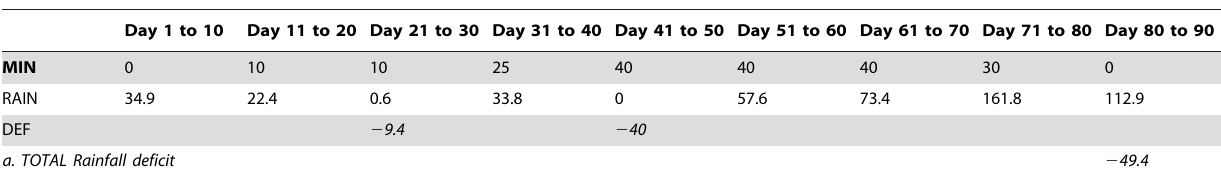
Table 4. Example of a season not entitled to an indemnity payment (total rainfall deficit does not reach the trigger value of 2 70 mm).